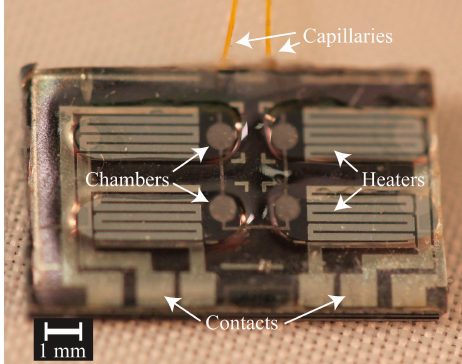
Figure 7. Photograph of pump with plena and capillary tubing. Visible are the interconnected capillary tubes, heaters, diaphragm chambers, plena, and heater contact pads. Heater miniaturization was limited by resolution of the printed transparency masks used in this work.